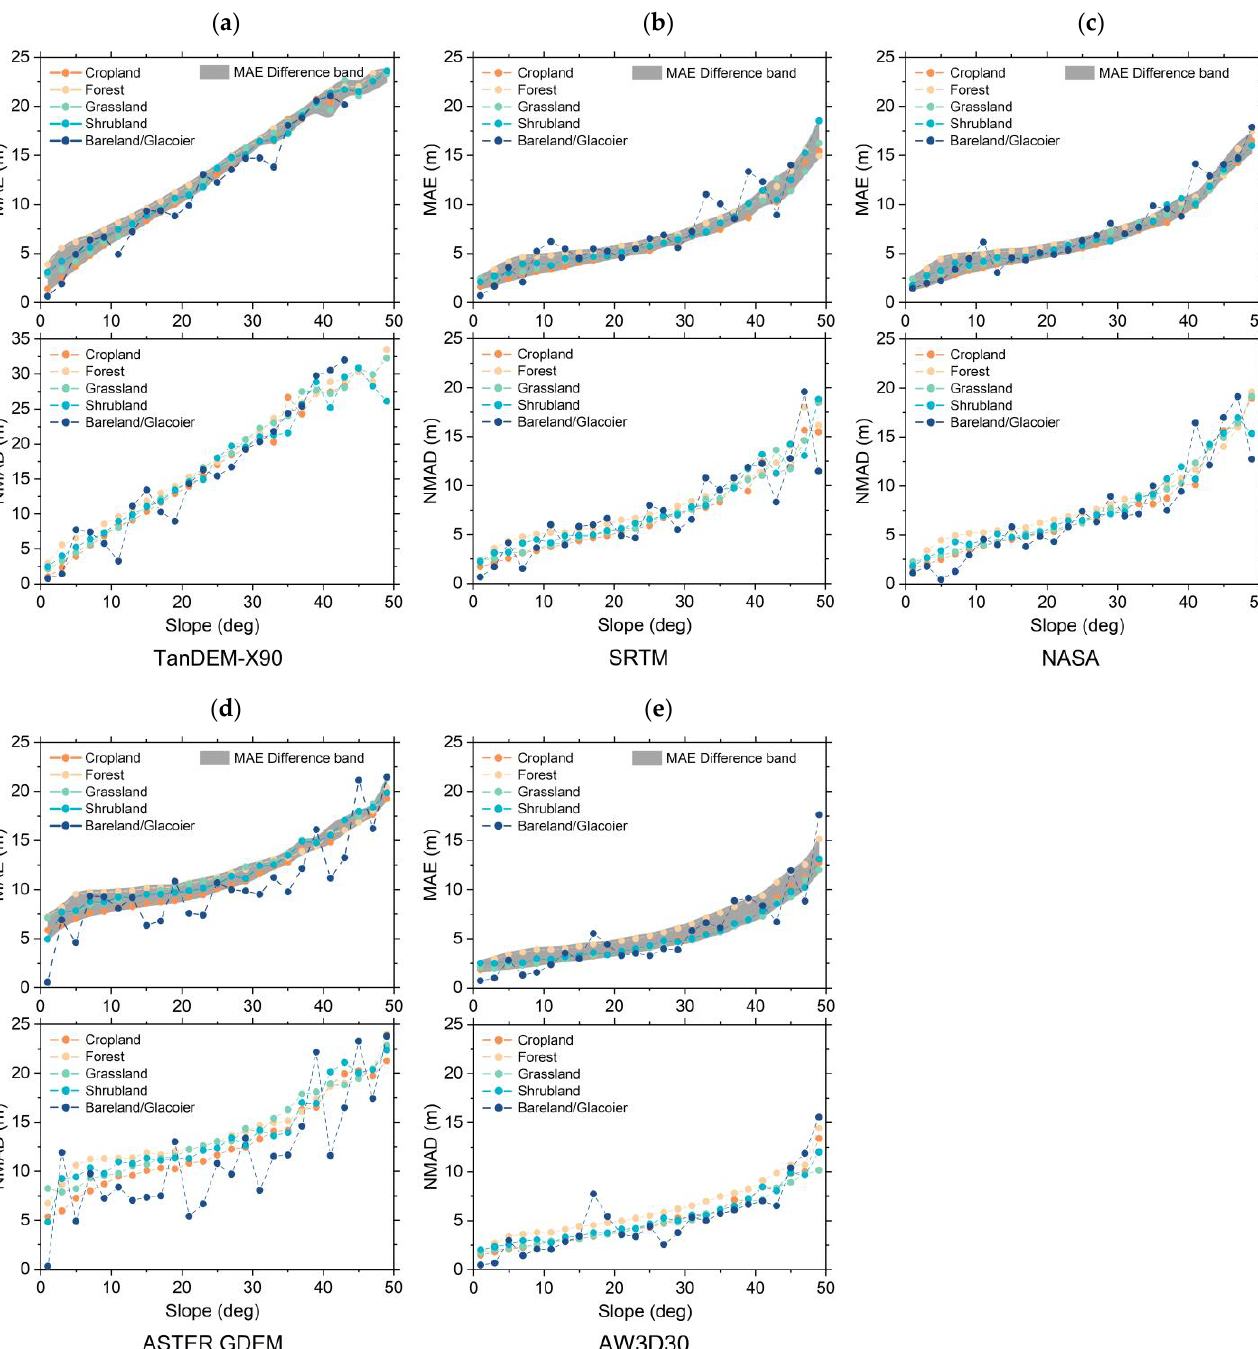
Figure 13. Slope-grouped boxplots of differences (i.e., bias) according to landcover types.